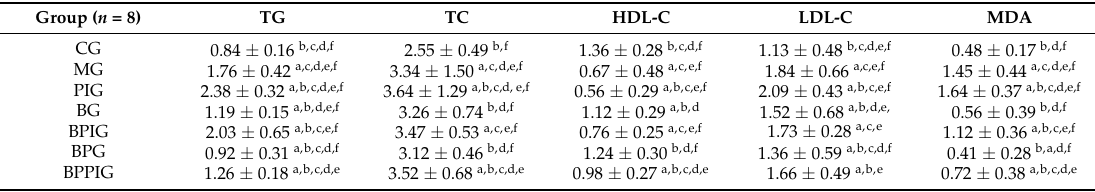
Table 7. Biochemical parameters of lipid metabolism for NASH (mmol/L).